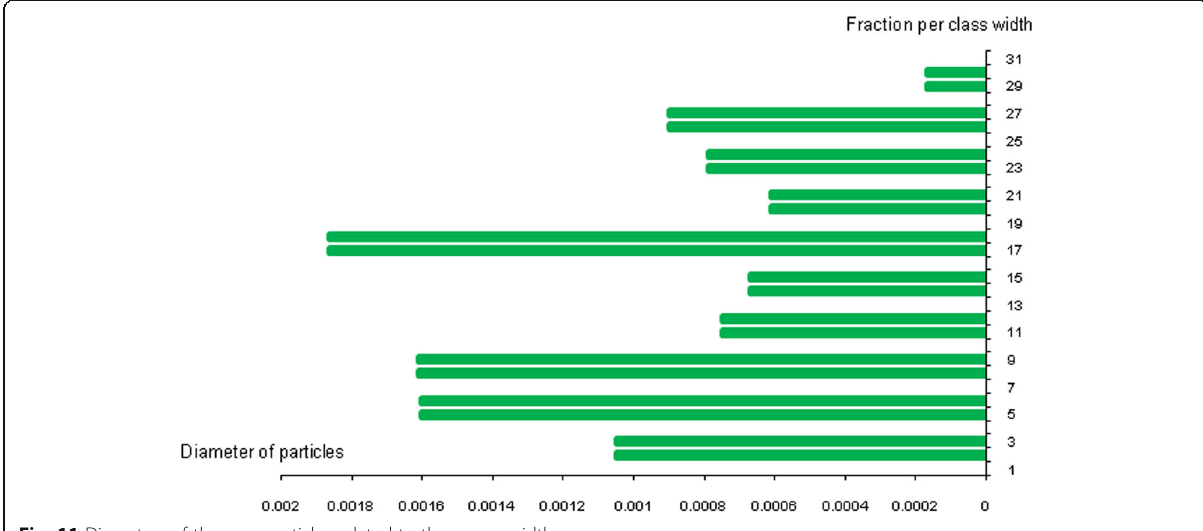
Fig. 11 Diameters of the nanoparticles related to the group width